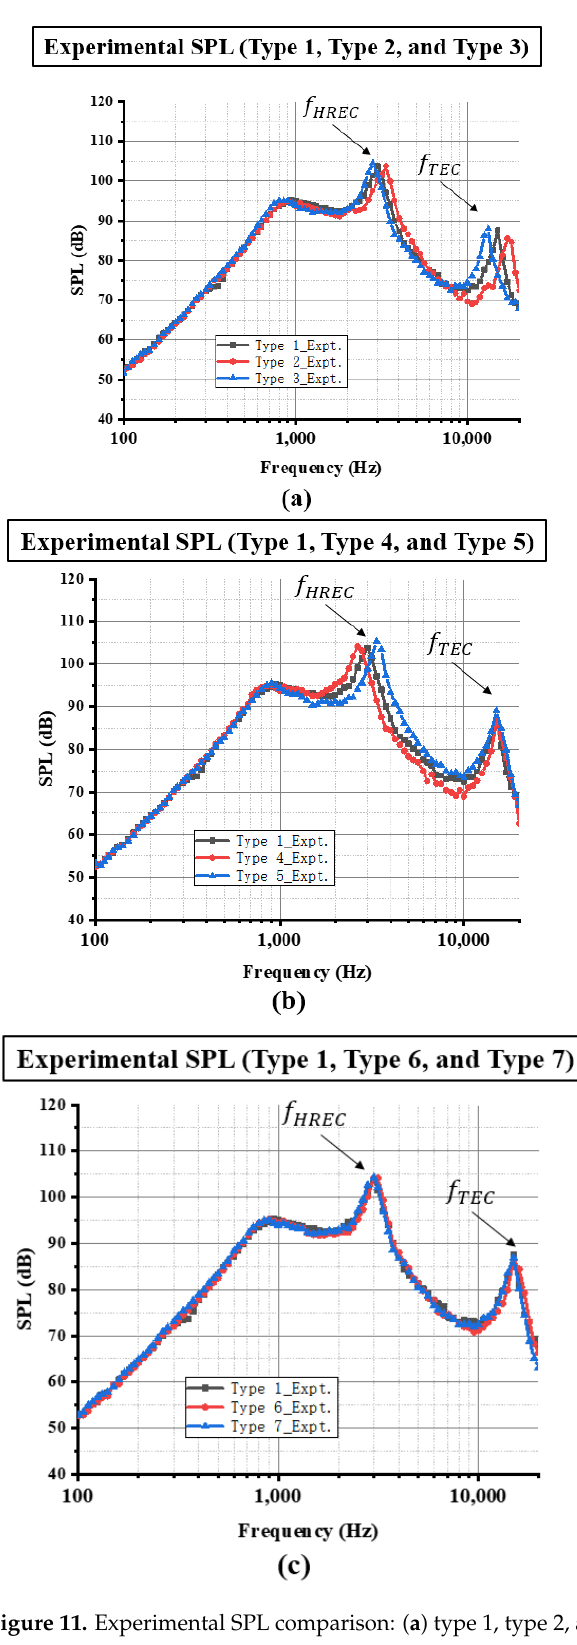
Figure 11. Experimental SPL comparison: ( a ) type 1, type 2, and type 3; ( b ) type 1, type 4, and type 5; ( c ) type 1, type 5, and type 6. Table 3. Peak frequencies comparison (All types).